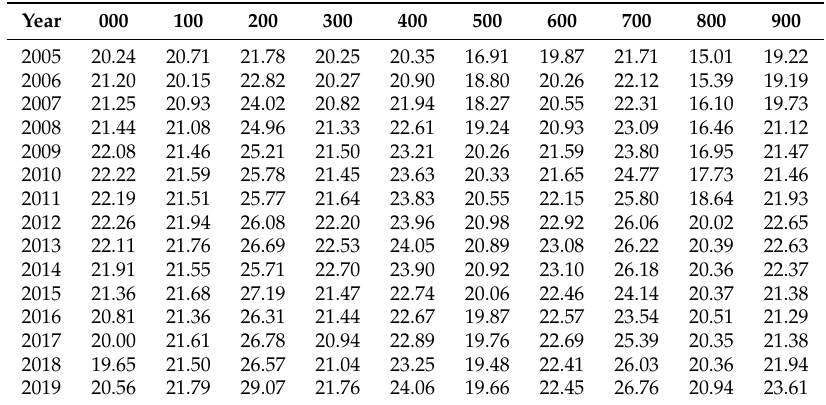
Table 3. Proportion (%) of core collections in each DDC class for each